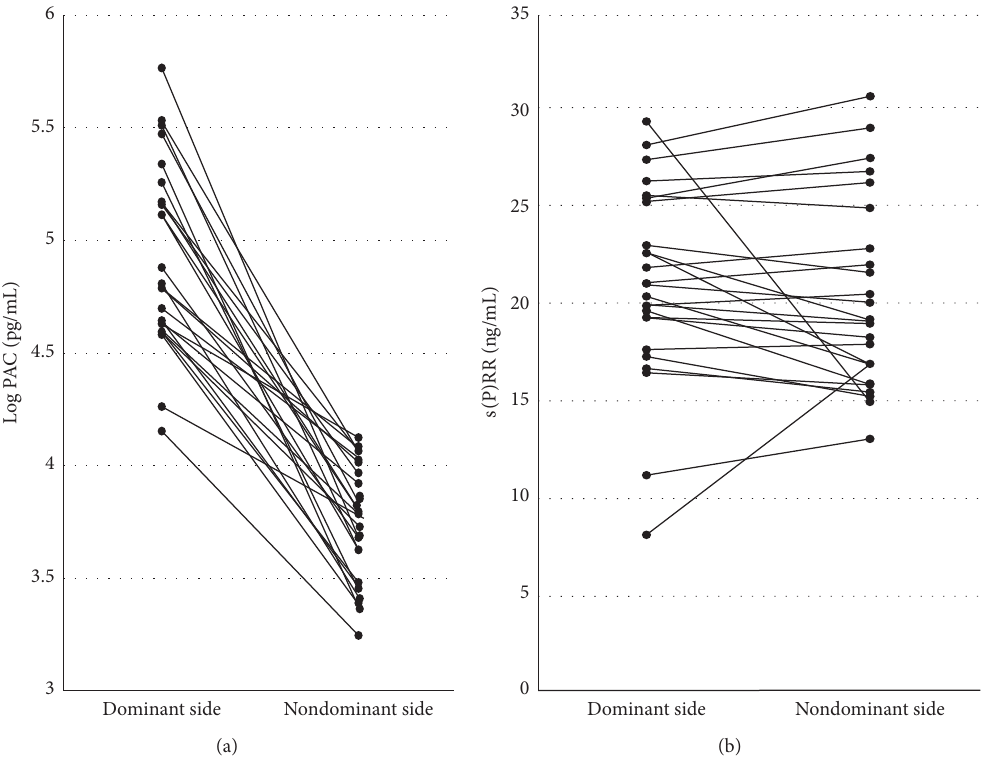
Figure 4: PAC and s(P)RR levels. Blood samples were collected from both dominant- and nondominant-side adrenal veins. (P)RR: (pro) renin receptor and PAC: plasma aldosterone concentration.